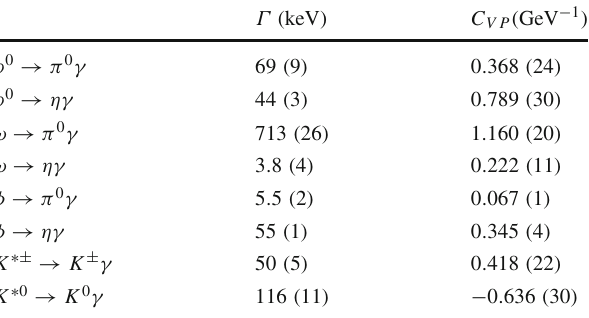
Table1 Radiativewidthsofvectormesonsandcorrespondingcoupling constants. The relative signs of the couplings are determined assuming flavour